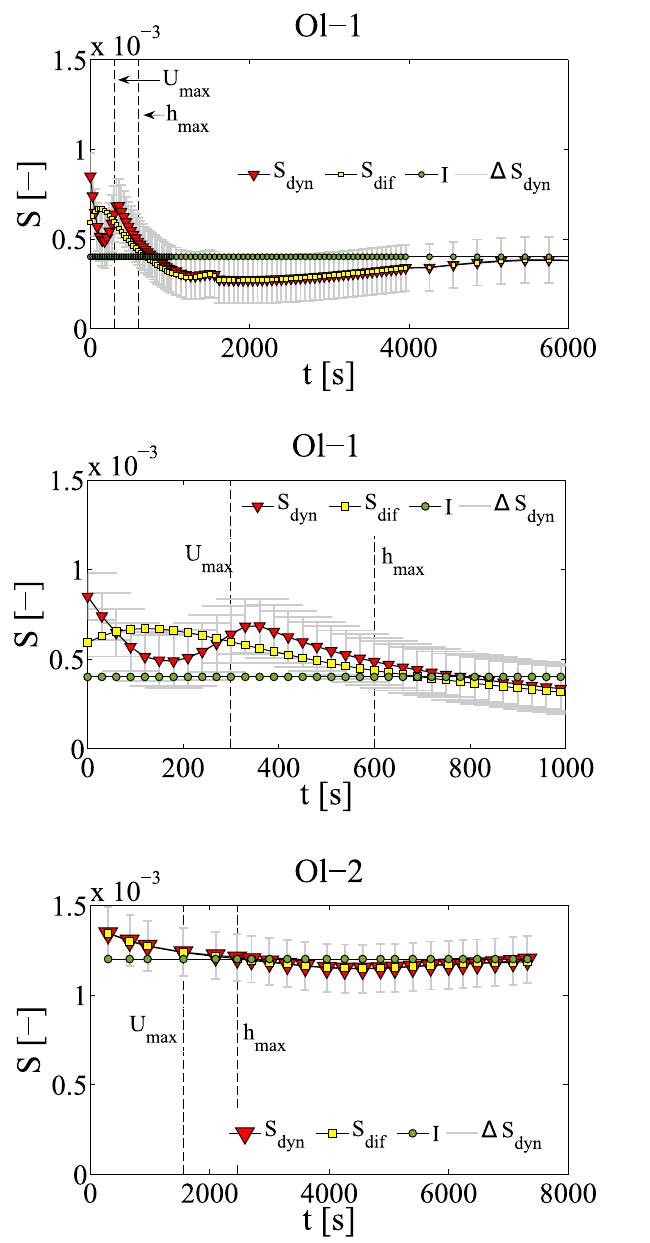
Figure 9. Comparison of friction slope evaluated by formulae for dynamic S dyn , diffusive wave S dif and steady flow I with uncer- tainty bounds (cid:49)S dyn for experimental flood waves in the Olszanka watercourse. Middle panel shows an enlargement of the rising limb of the wave for Ol-1.